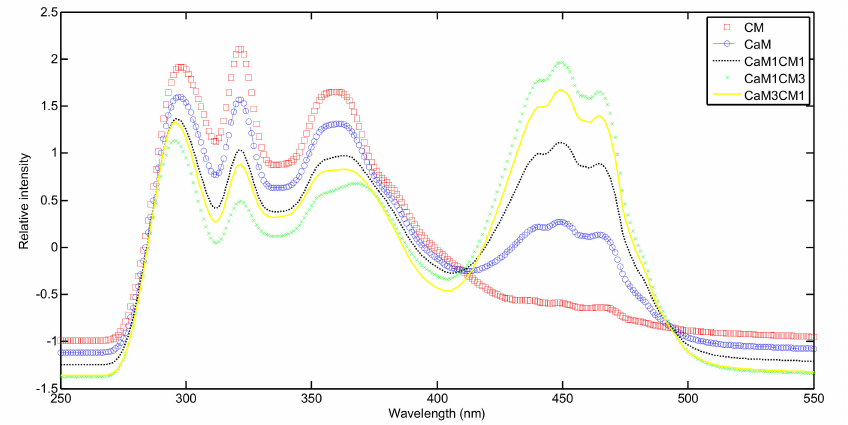
Figure 1. Normalized mean synchronous fluorescence spectra recorded during coagulation of CM (cow’s milk), CaM (camel’s milk) and their